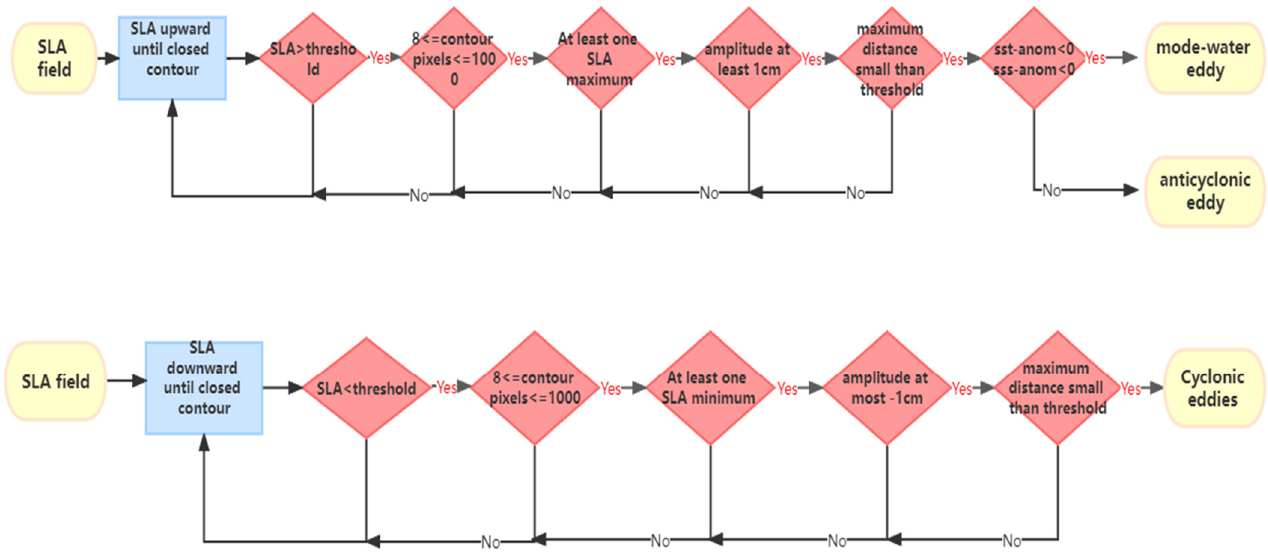
Figure 2. The flowchart of the identification method of mesoscale eddies.